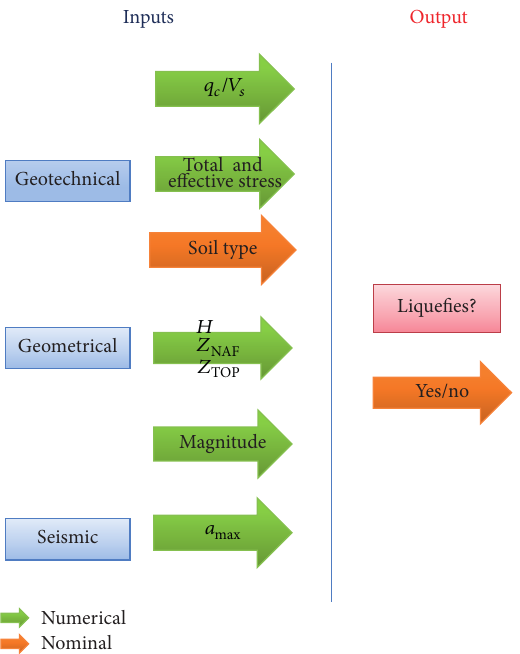
Figure 20: Inputs-output